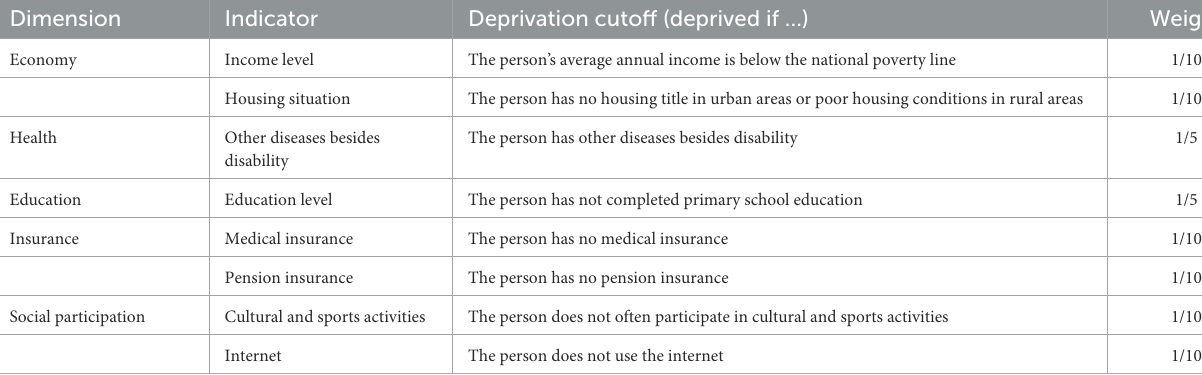
TABLE 1 Dimensions, indicators, deprivation criteria and